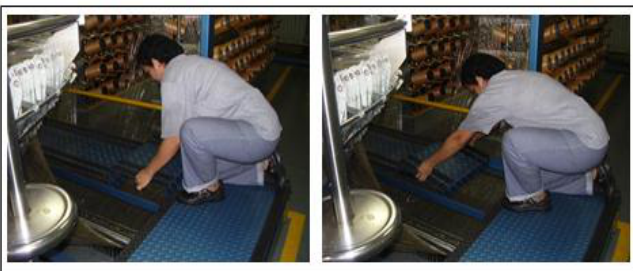
Figura 2: Mostra a colaboradora puxando a base do Piso da Máquina da Tecelagem Circular.